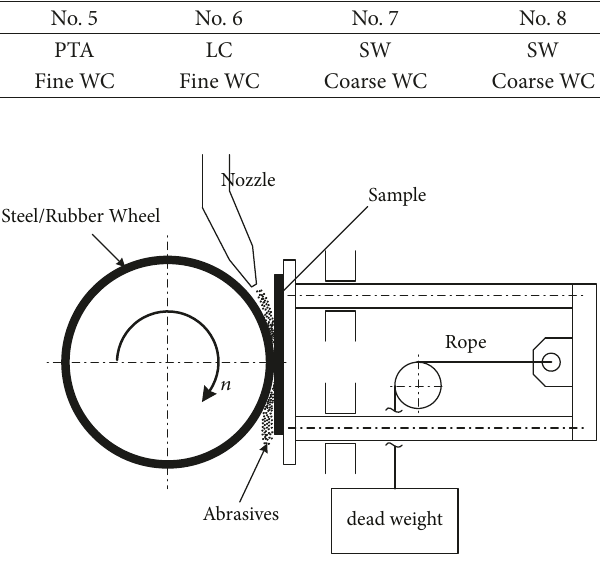
Figure 2: Test setup and sample